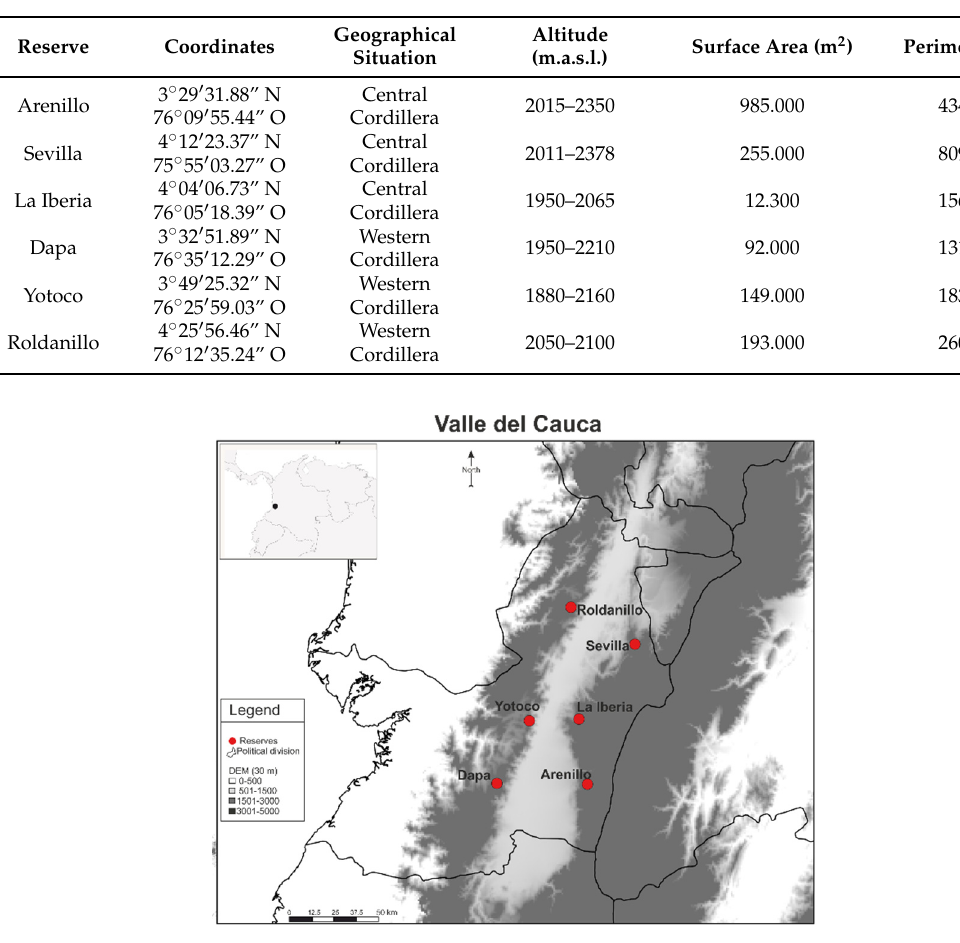
Table 1. Location, surface area and perimeter of the cloud forest protected areas under study.